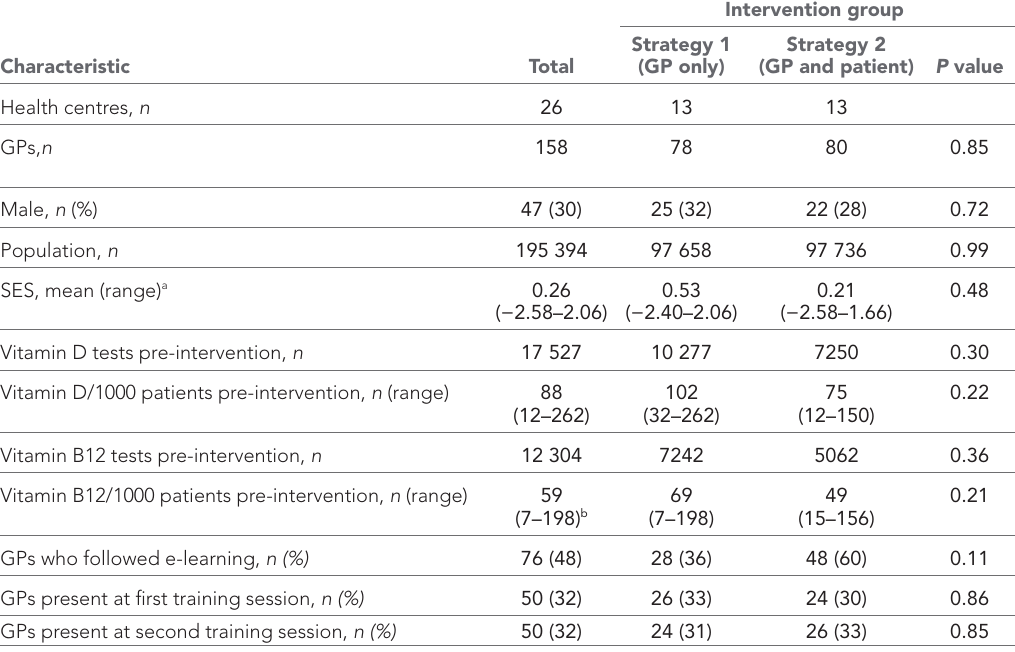
Table 1 Baseline characteristics of participating GPs, including pre- intervention numbers of vitamin